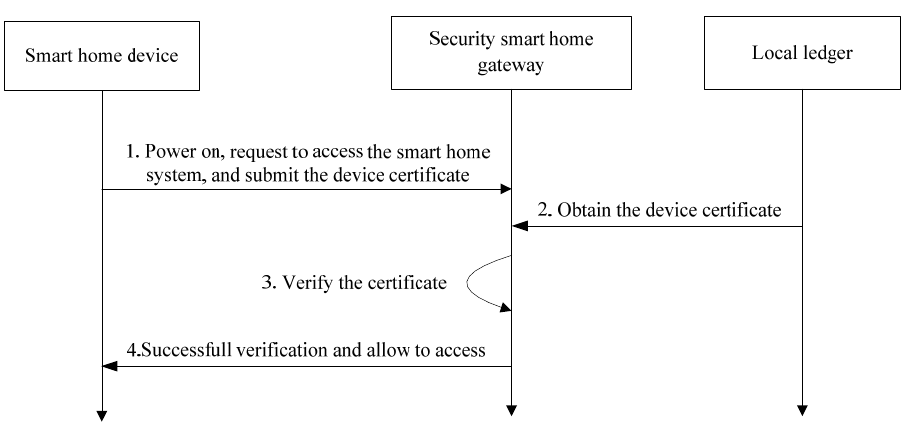
Figure 8. Access control processing of smart home device.